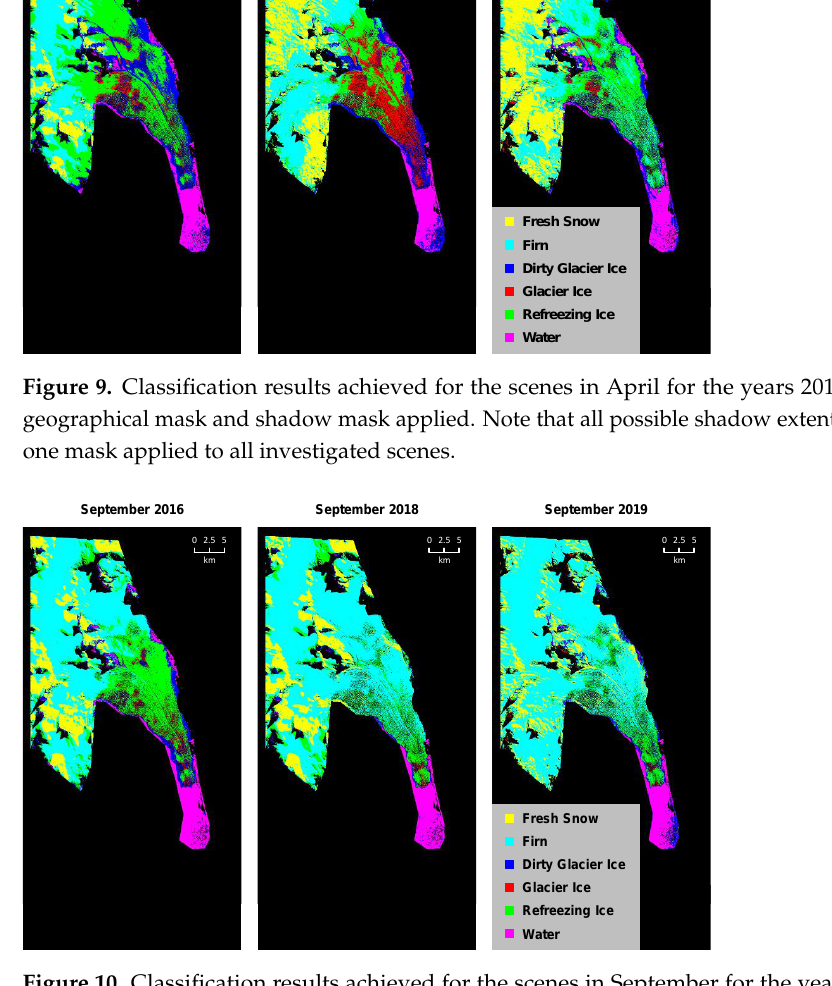
Figure 10. Classification results achieved for the scenes in September for the years 2016, 2018 and 2019, geographical mask and shadow mask applied. Note that all possible shadow extents are excluded by one mask applied to all investigated